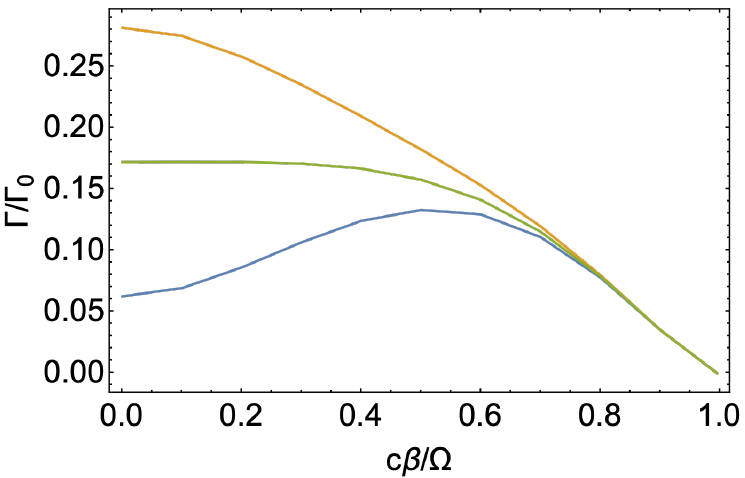
Figure 6. Total photon creation rate for the system considered in Figure 4 for TE (blue), TM (orange), and circularly (green) polarized